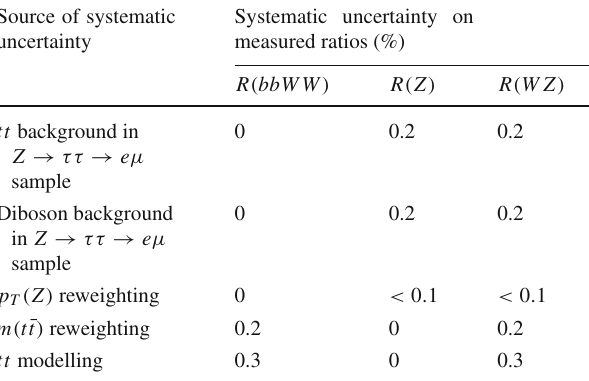
Table 5 Changes in the ratios R ( bbWW ) , R ( Z ) , and R ( W Z ) resulting fromthesourcesofphenomenologicalsystematicuncertaintydescribed in Sect. 2.2 and summarised in Table 2 Source of systematic